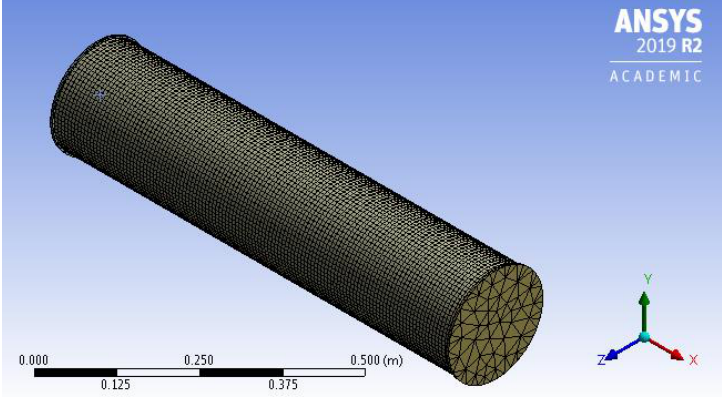
Figure 5. Most refined mesh used for the unstiffened shell case.